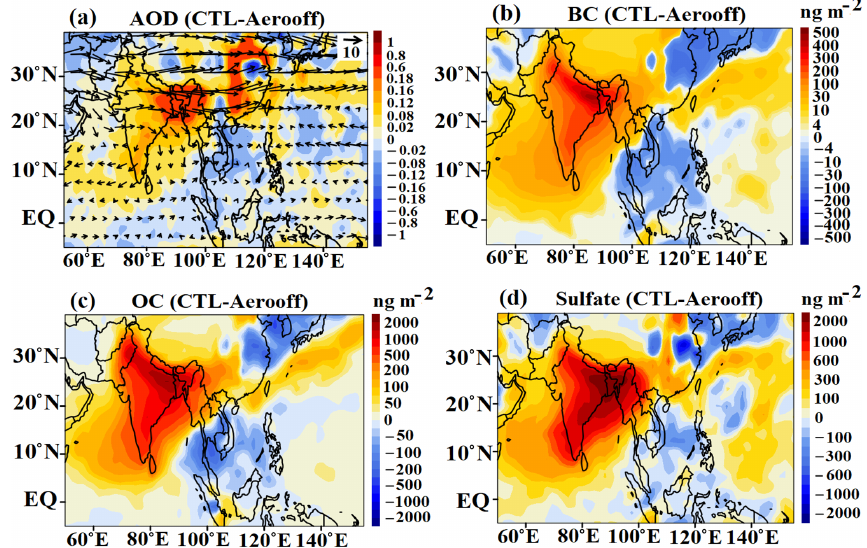
Figure 2. Spatial distribution of (a) AOD anomalies averaged for spring during 2001–2016 (CTL-Aerooff) and anomalies of tropospheric column of (b) BC, (c) OC, and (d) sulfate aerosols (ngm − 2 ) (CTL-Aerooff). The vectors in Fig. 2a indicate winds (ms − 1 ) at